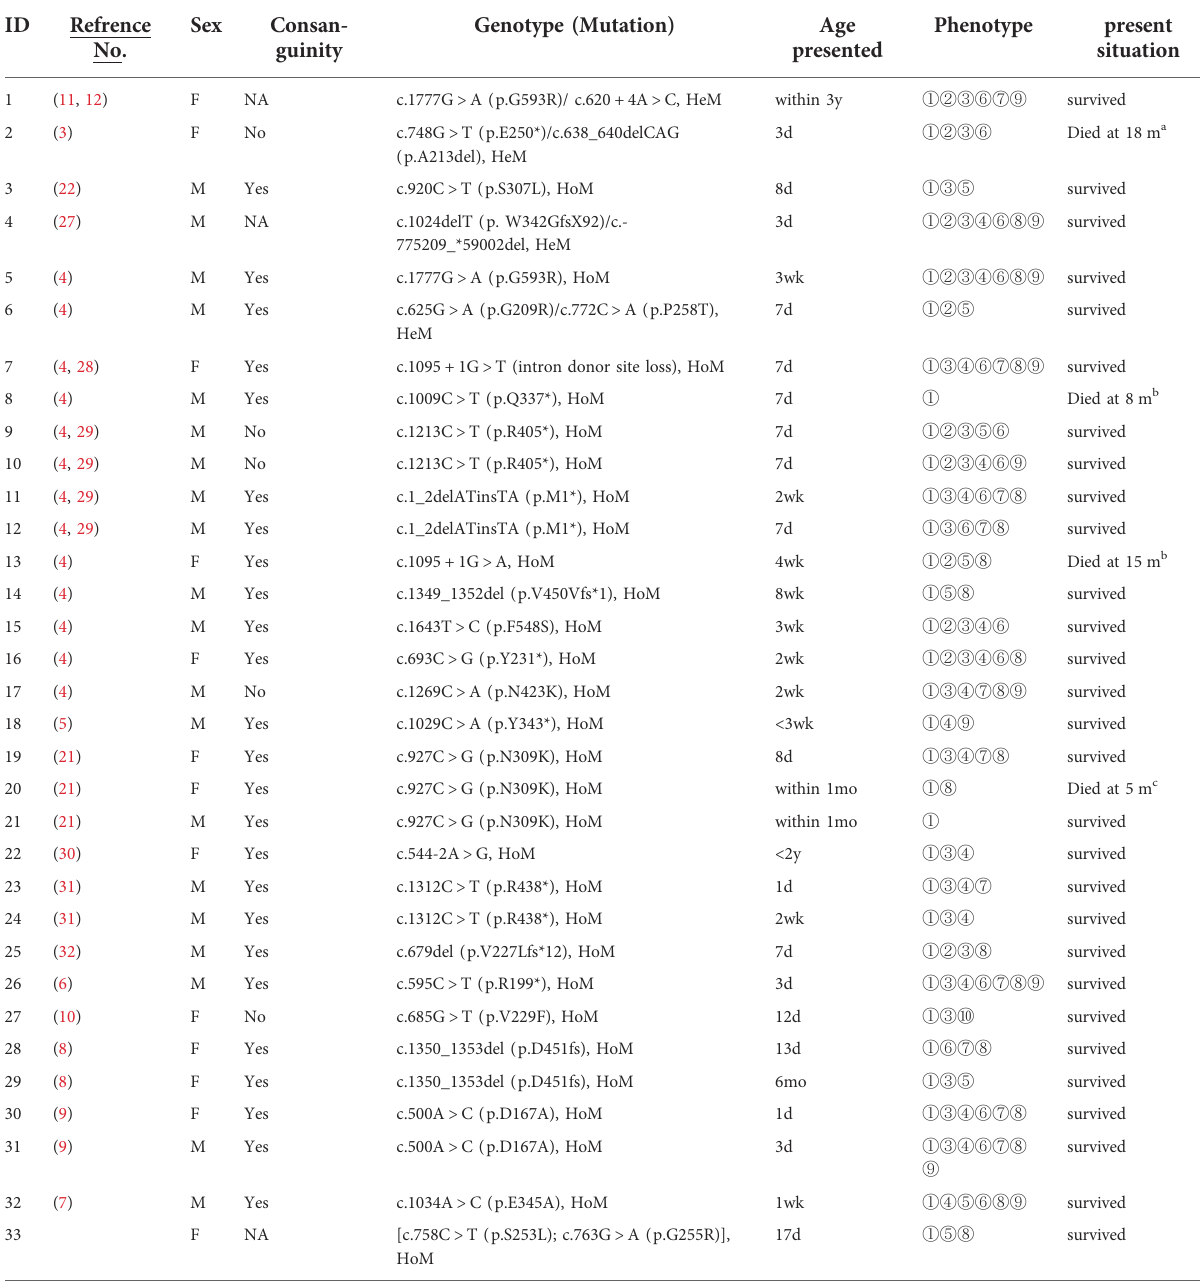
TABLE 2 Overview of PC1/3-de fi cient patients: genotype and clinical phenotypes. ID Refrence